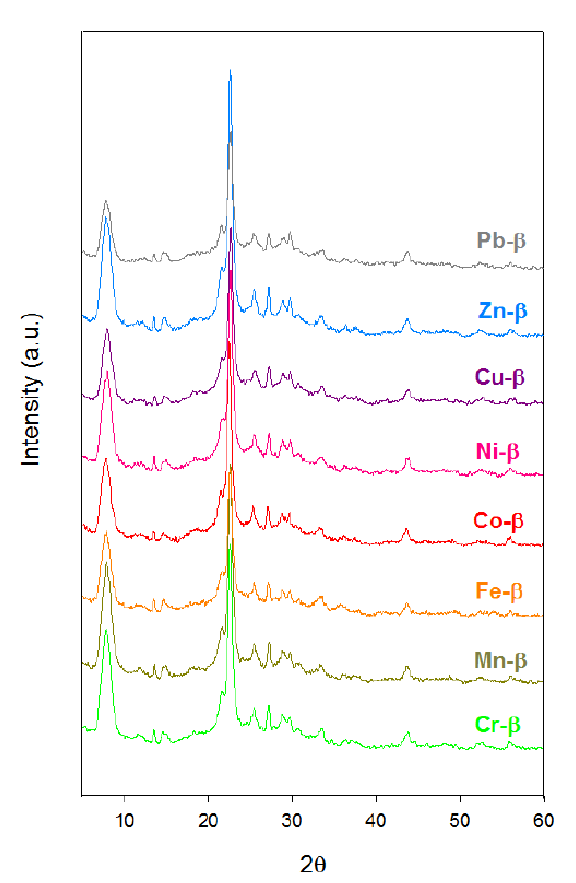
Figure 1. Powder X-ray diffraction patterns for metal exchanged β